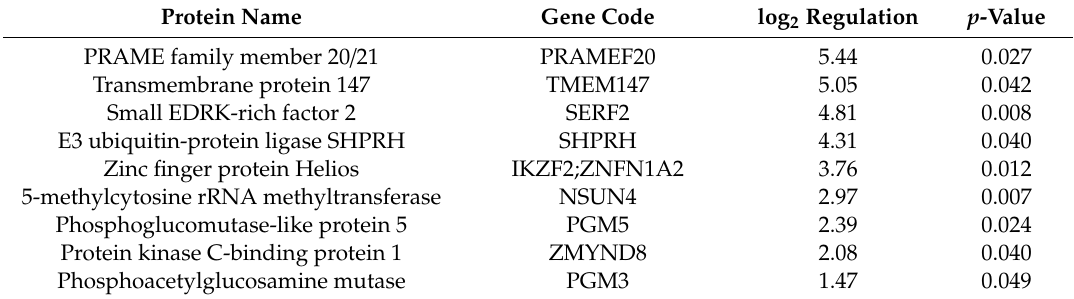
Table 2. Strongest upregulated proteins after CBZ treatment.